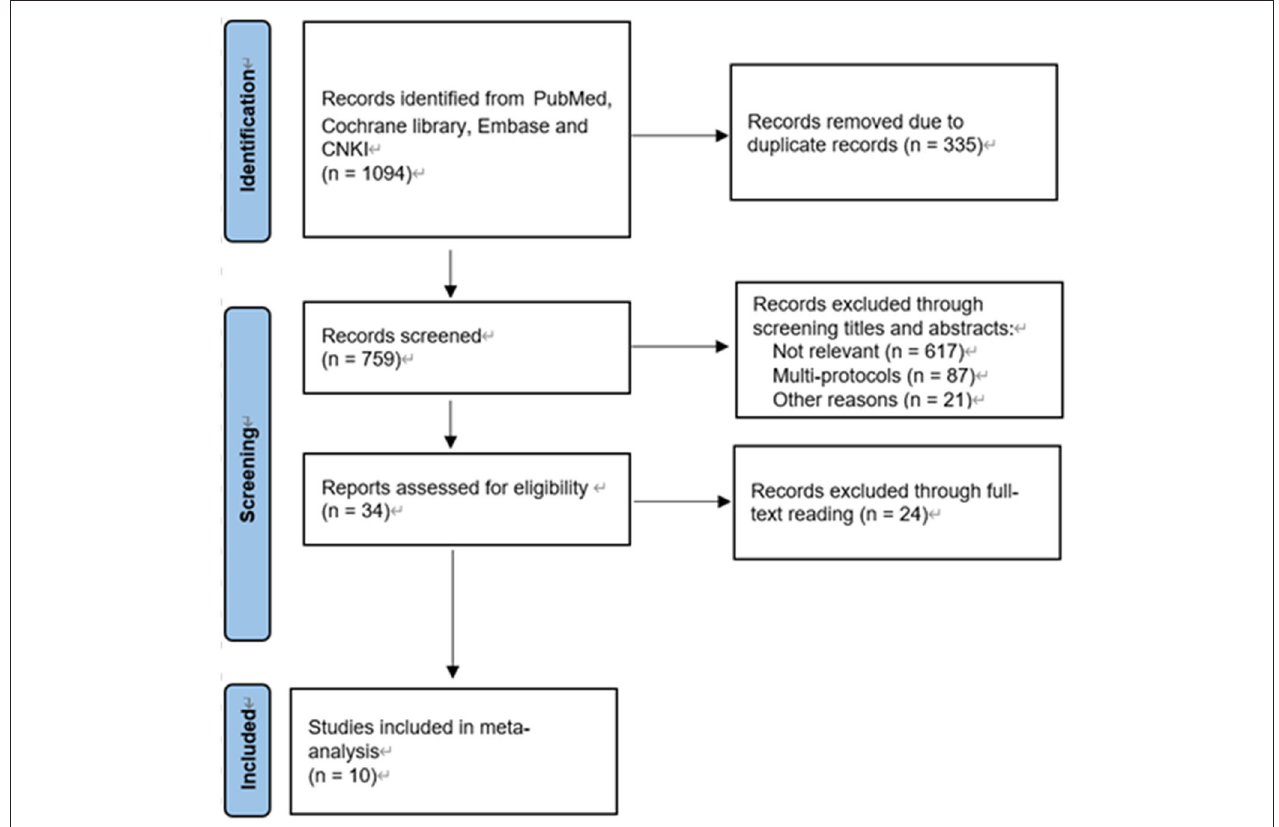
FIGURE 1 | Flow diagram of study